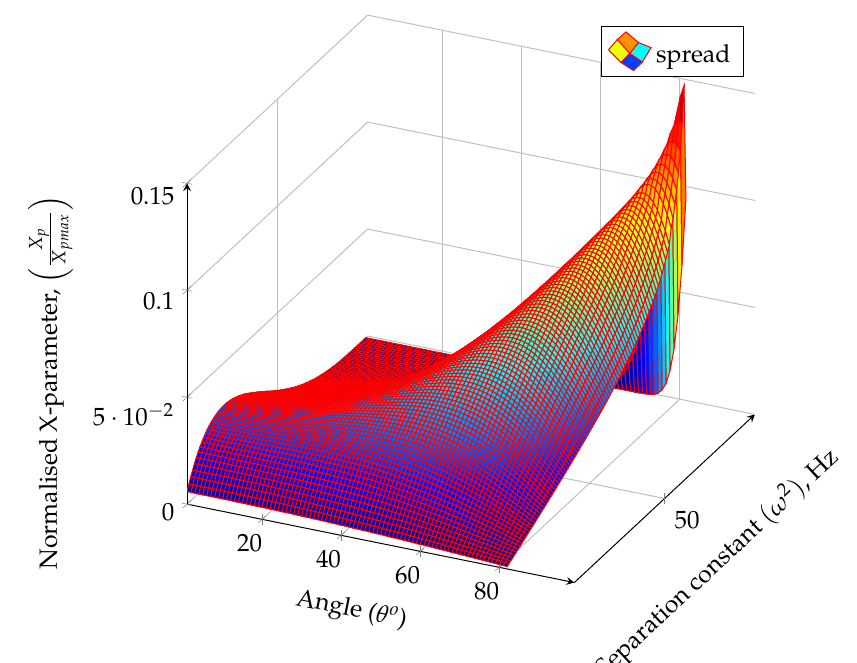
Figure 10. 3D plot of X -parameter ( X p ) as a function of the separation constant ( ω 2 ) and angle ( θ ◦ ) at time t = 70 d.